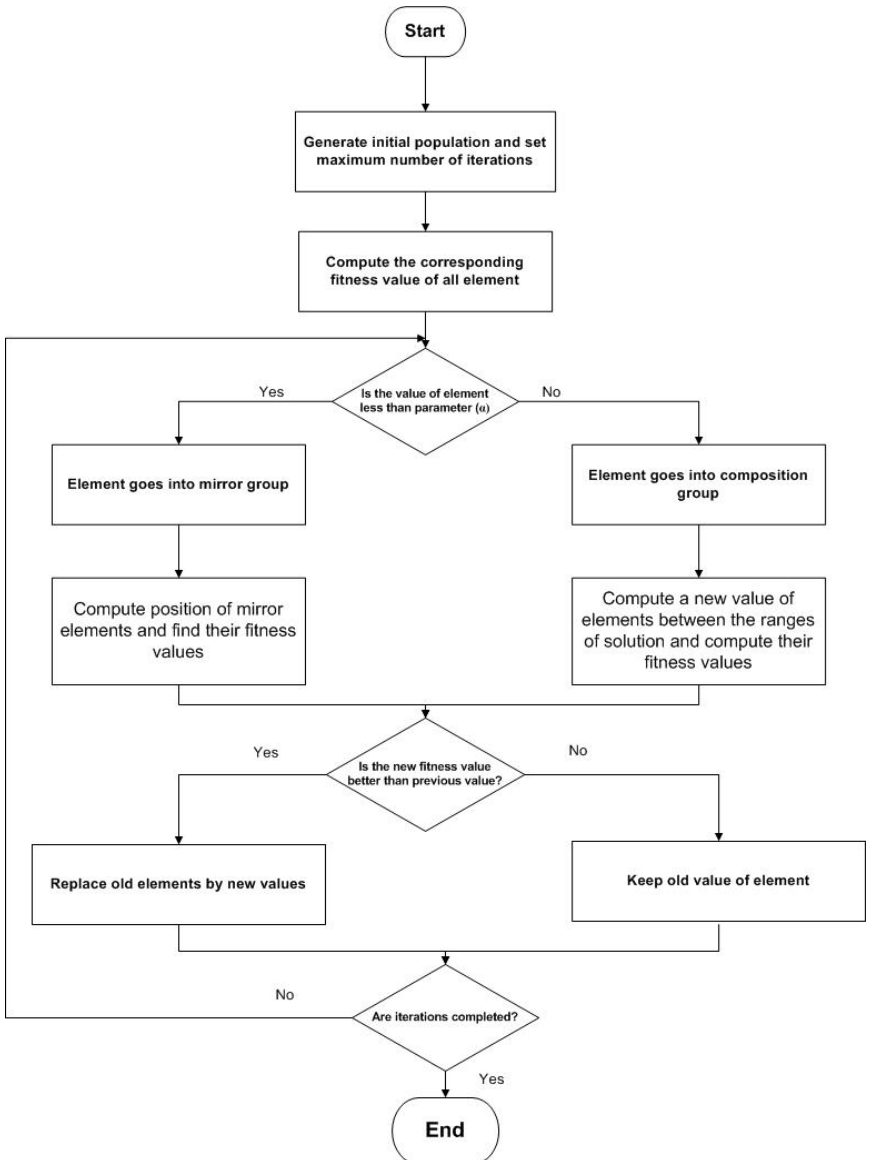
Figure 4. ISA flowchart.